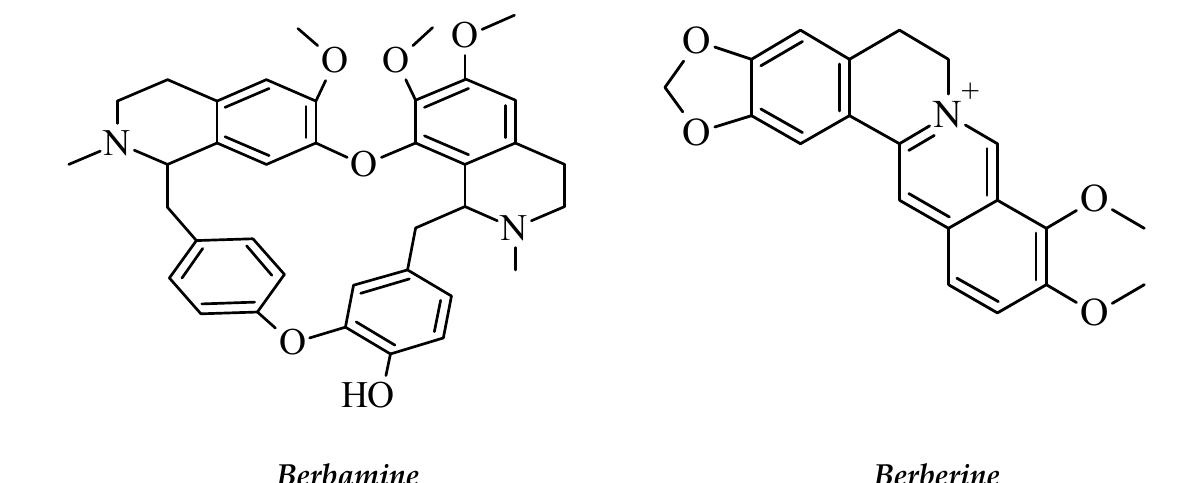
Figure 14. The structures of berbamine and berberine.